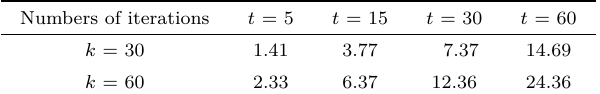
Fig. 23 An example showing poor